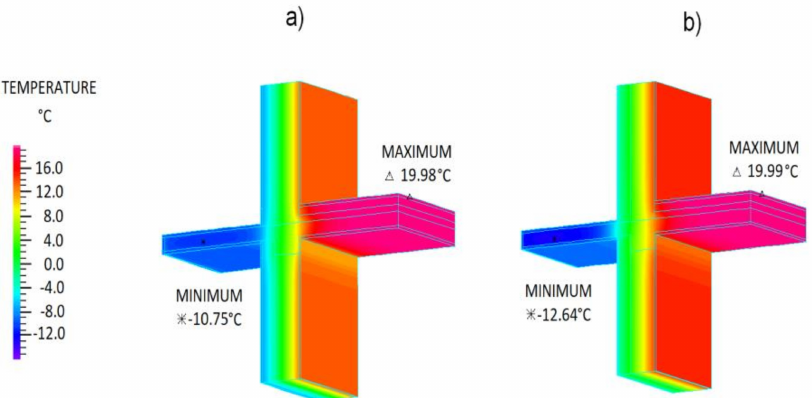
Figure 9. Temperature distribution in the model at the time of the lowest temperature on the inner wall surface; ( a ) variant 1, ( b ) variant